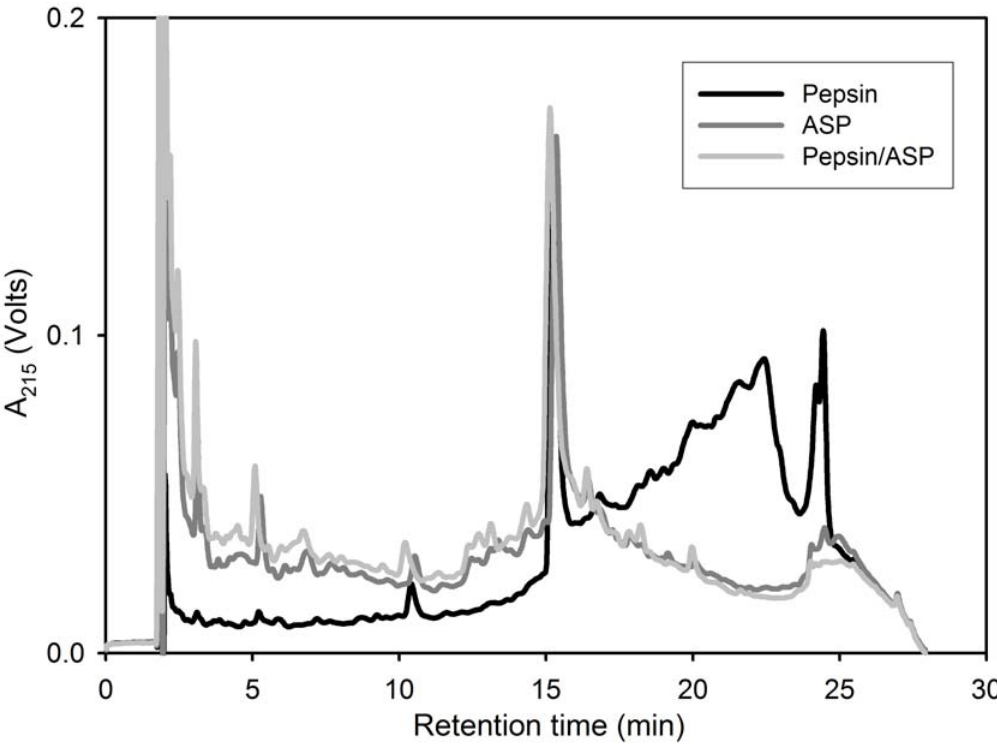
Figure 3. Proteolysis of whole gluten by aspergillopepsin (ASP) under simulated gastric conditions. Whole gluten powder (15 mg/ml) was incubated with either 0.35 mg/ml ASP, 0.6 mg/ml pepsin, or both enzymes at 37 u C for 60 min at pH 2. The resulting product mixture was analyzed by reverse-phase HPLC, as described in the text. The breakdown of longer gluten peptides into shorter ones is generally indicated by a decrease in absorbance at higher retention times and a concomitant increase in absorbance at lower retention times. The peak at 15 min corresponds to an internal standard (TAME).